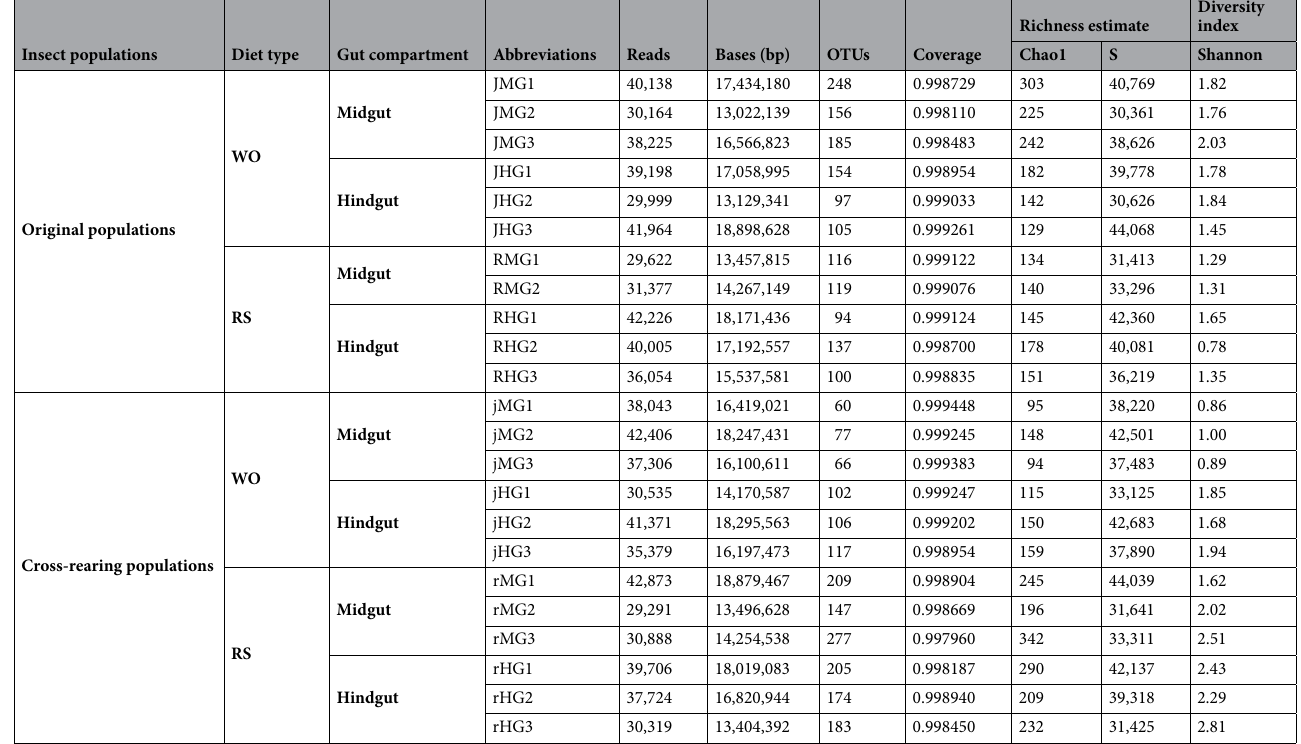
Table 2. Diversity of gut bacterial communities based on sequencing. S number of sequences, WO water-oat, RS rice